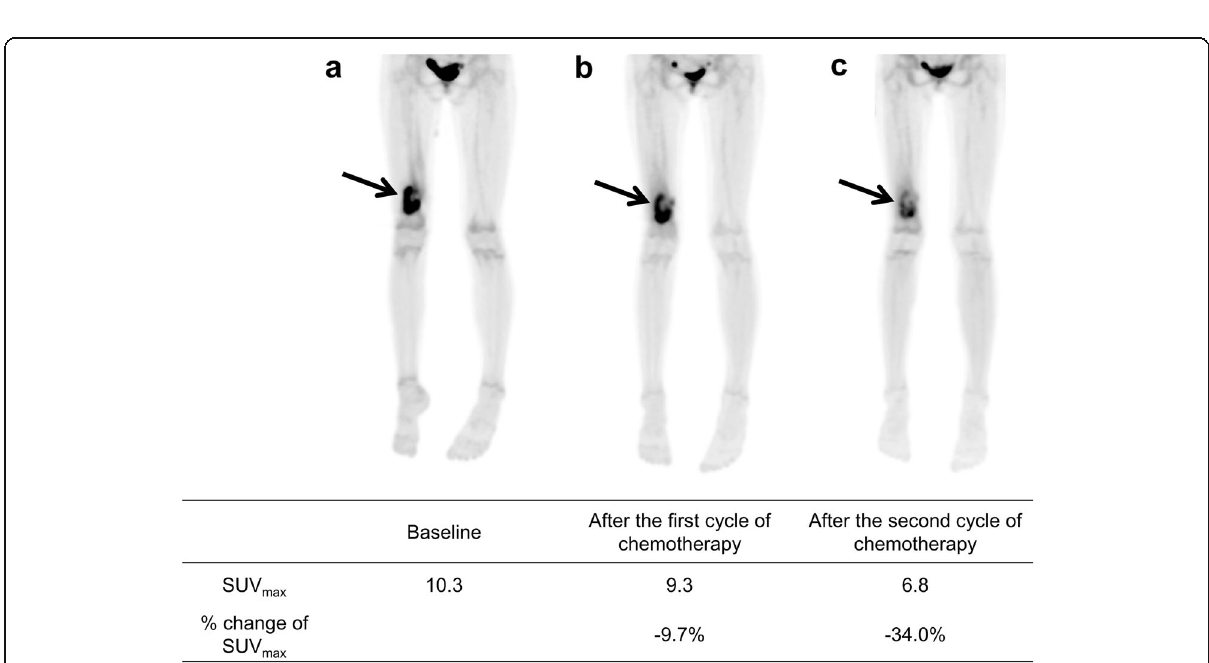
Fig. 3 Maximum intensity projection images of [ 18 F]FDG PET on the baseline ( a ), after the first cycle of neoadjuvant chemotherapy ( b ), and after the second cycles of neoadjuvant chemotherapy ( c ) of an 11-year-old female with osteosarcoma of the right femur. After neoadjuvant chemotherapy, SUV max has reduced only by 9.7% and 34.0% after 1 cycle and 2 cycles of neoadjuvant chemotherapy, respectively. Although the patient showed a good histologic response to neoadjuvant chemotherapy, pulmonary metastasis developed 16 months after